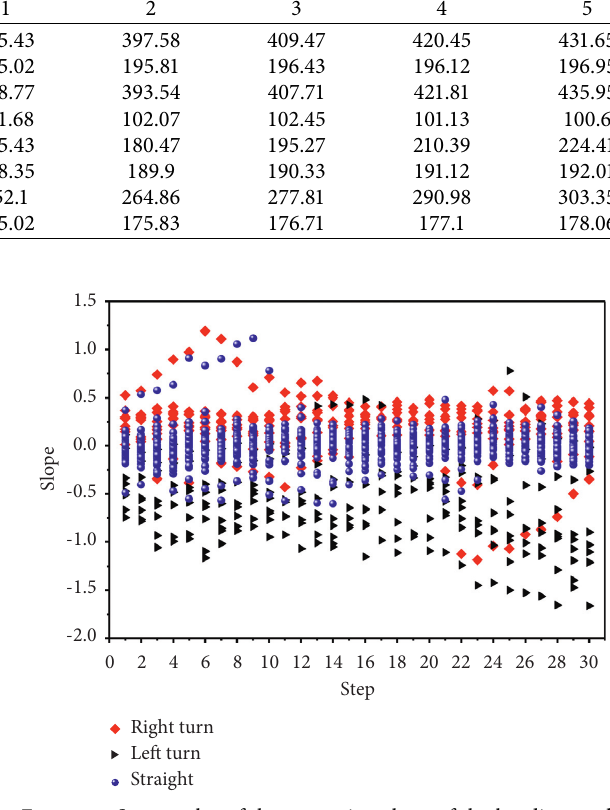
Figure 7: Scatter plot of the regression slope of the heading angle for each